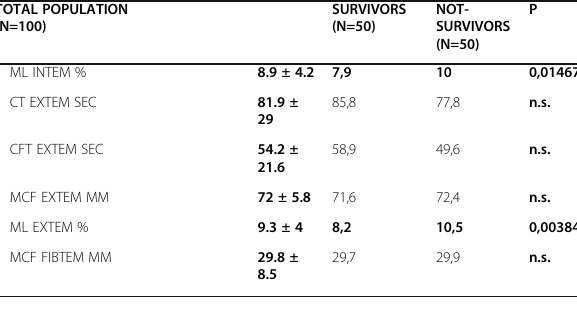
Table 1 (abstract A185). See text for description (Continued) TOTAL